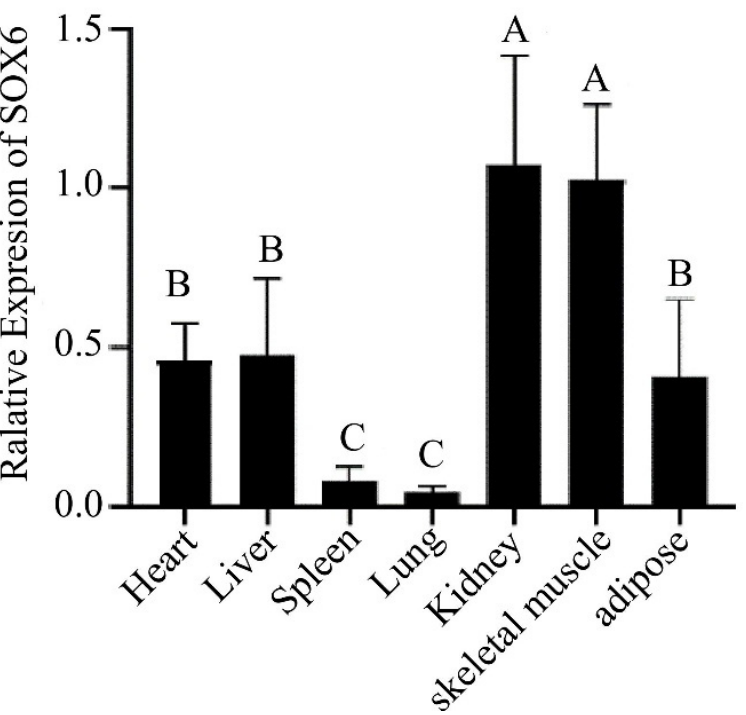
Figure 2. Tissues expression of SOX6 in the Ashidan yak. Different capital letters (A, B, C) represent the extremely significant differences ( p < 0.01).